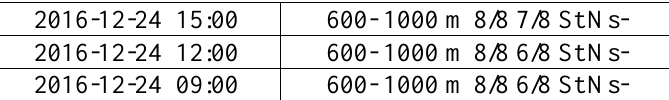
Table 6: The weather forecast for Duhok.